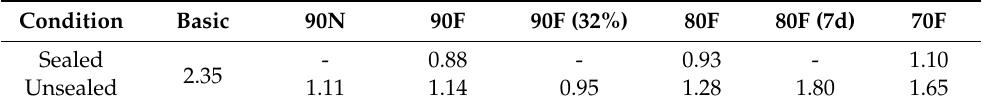
Figure 13. Total strain of 90 MPa concrete calculated from compressive creep coefficients that corrected through measured values and predicted through ACI 209: ( a ) sealed; ( b ) unsealed. Table 6. Modified constants 𝑎 in Equation (9).